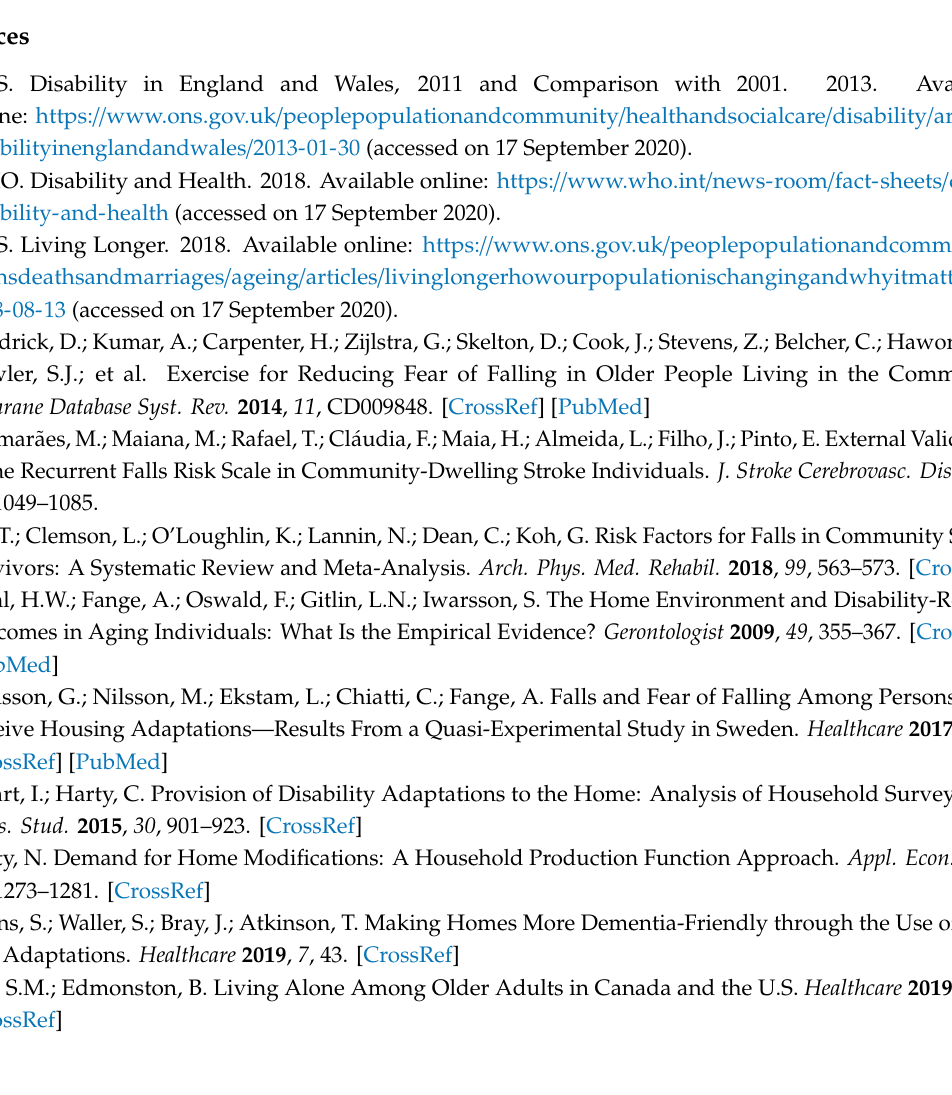
Figure A1. Shares of different types of home adaptations.